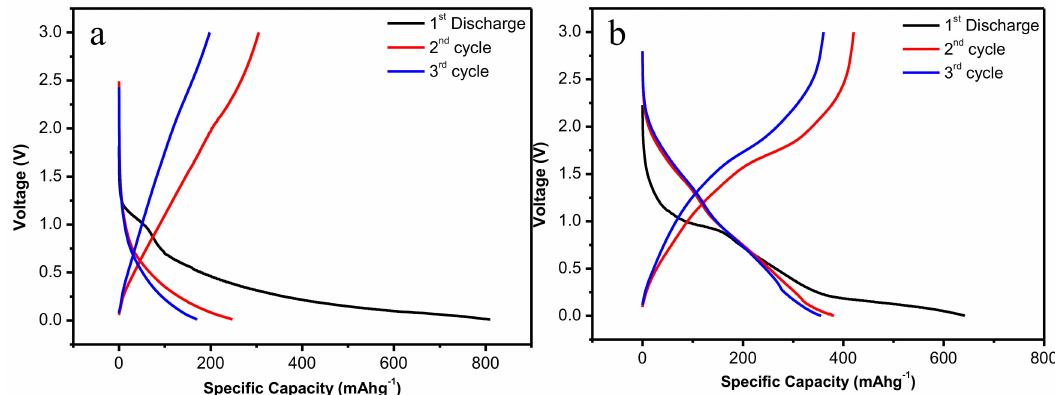
Figure 7. Electrochemical properties: the initial charge–discharge profiles at 50 mAg − 1 current density for ( a ) MS-0; ( b )